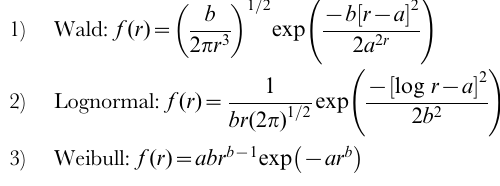
Table 1. Characteristics of the study